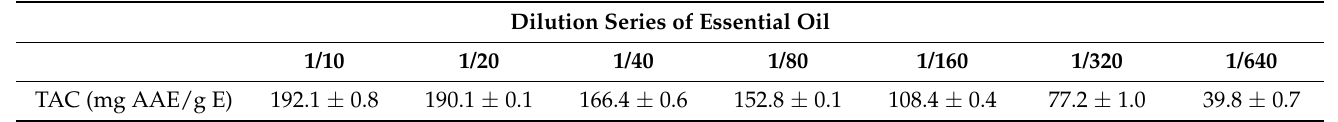
Table 4. Disc diffusion test for essential oil from D. viscosa (EOD), performed on six pathogenic strains and using antibiotics for comparison. Inhibition zone diameter in mm. Results are expressed as mean ± SD.